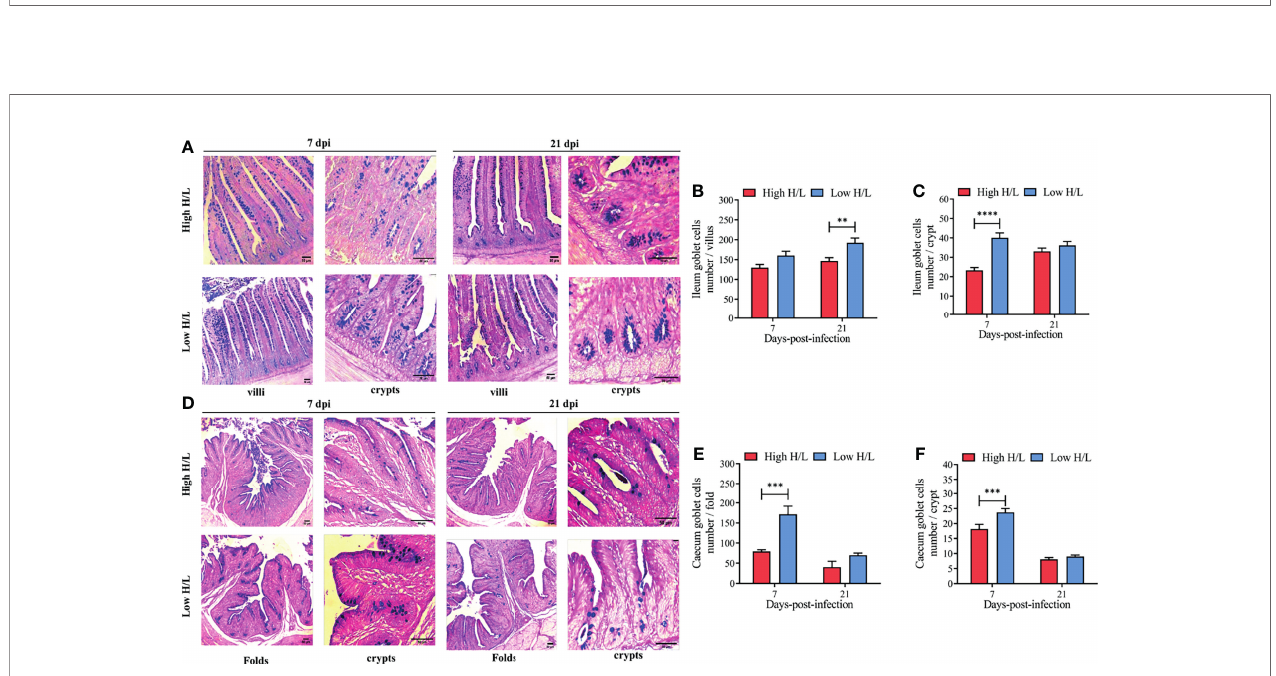
FIGURE 2 | Low H/L ratio chickens exhibit higher ileal and cecal goblet cells number under S. Enteritidis infection at 7 and 21 dpi. (A) ileum villi and crypt goblet cells distribution at 7 and 21 dpi; (B) Ileum goblet cells number in the villi at 7 and 21 dpi; (C) Ileum goblet cells number in the crypts at 7 and 21 dpi; (D) Caecum folds and crypt goblet cells number distribution at 7 and 21 dpi; (E) Caecum goblet cells number in the folds at 7 and 21 dpi. (F) Caecum goblet cells number in the crypts at 7 and 21 dpi; **p < 0.01, ***p < 0.001, ****p < 0.0001. Data analysis was performed using 2-way ANOVA with Sidak ’ s multiple comparisons, with alpha = 0.05. Images were captured at 100X magni fi cation (n = 2; 10 villi and 20 crypts each bird).